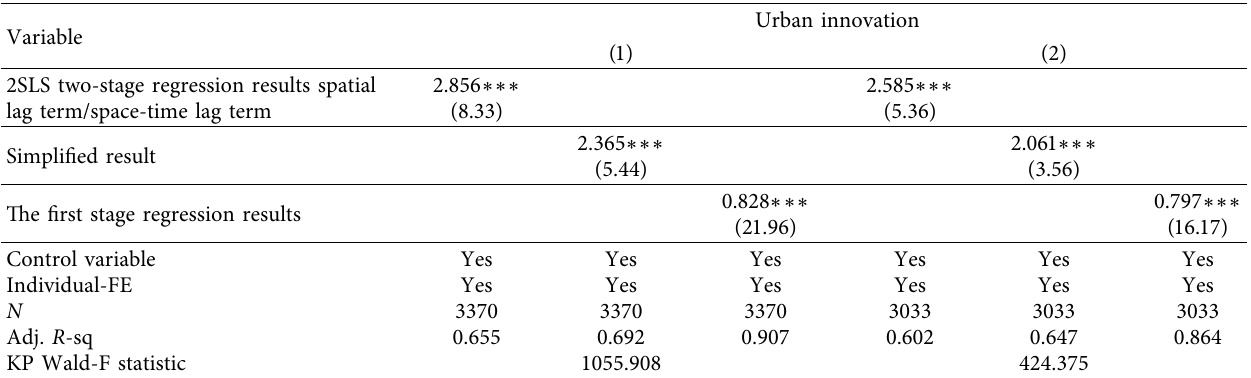
Table 6: Results of instrumental variables estimation for impact of the digital economy on urban economy.